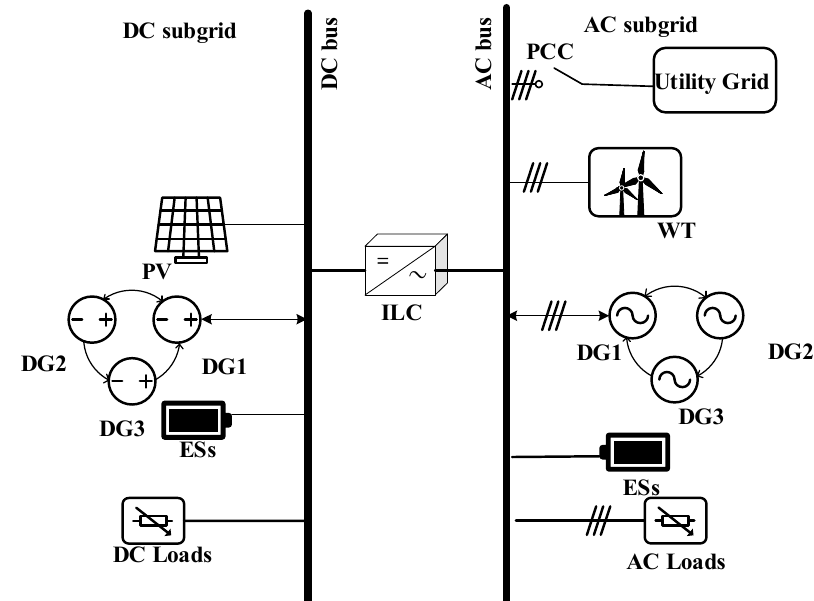
Figure 1. Main structure of hybrid AC/DC microgrid.